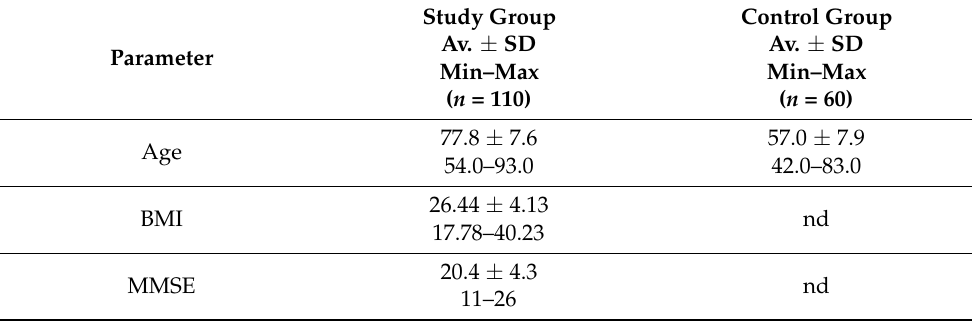
Table 1. Characteristics of the study and control